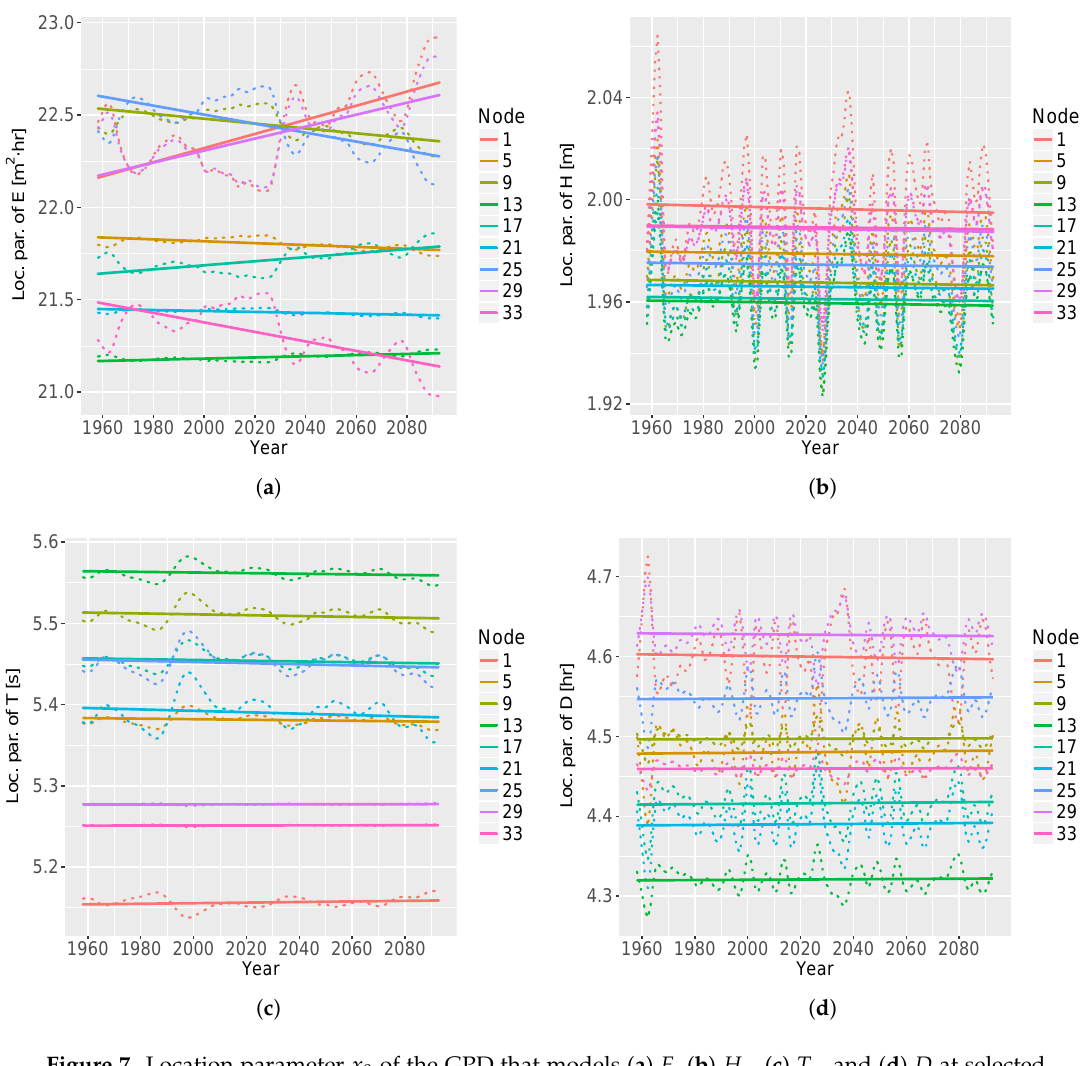
Figure 7. Location parameter x 0 of the GPD that models ( a ) E , ( b ) H p , ( c ) T p , and ( d ) D at selected nodes, under the RCP8.5 scenario. The second time-derivative of EA was used in the VGAM to predict the location parameter x 0 of H p . The NAO was used in the VGAM to predict the location parameter x 0 of T p . The location parameter x 0 of E and D are not affected by the selected climate indices. The time series are approximated by a straight line, which helps to see the trend of the location parameters x 0 at each